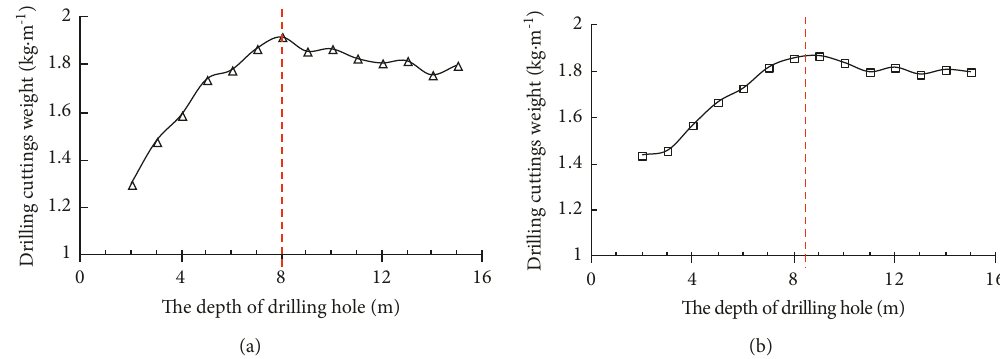
Figure 15: The average value of on-site drilling cuttings weight inside the roadway ribs. (a) The left rib; (b) the right